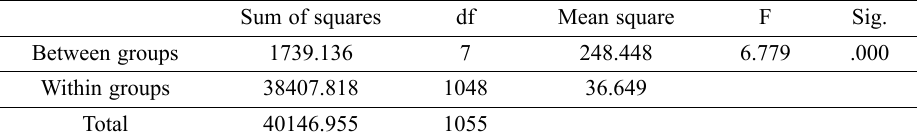
Table 3. ANOVA results for the groups